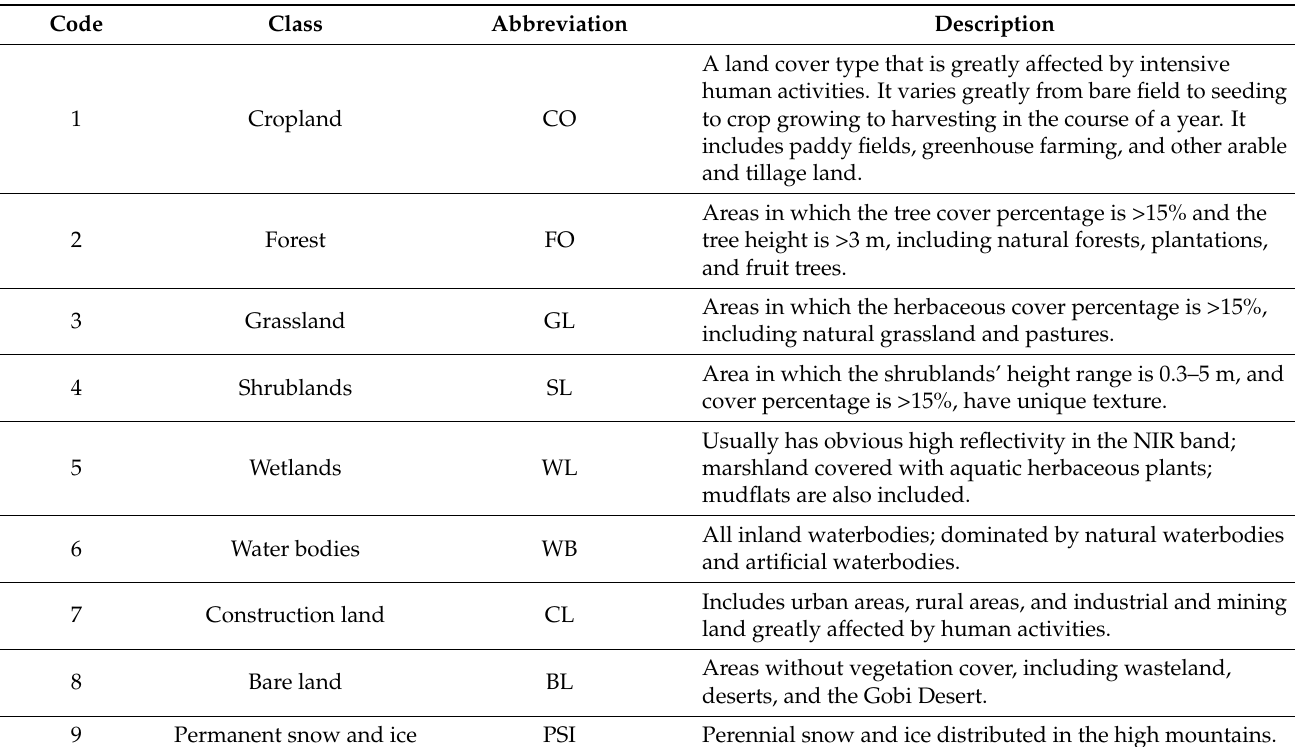
Table 2. Land cover classification